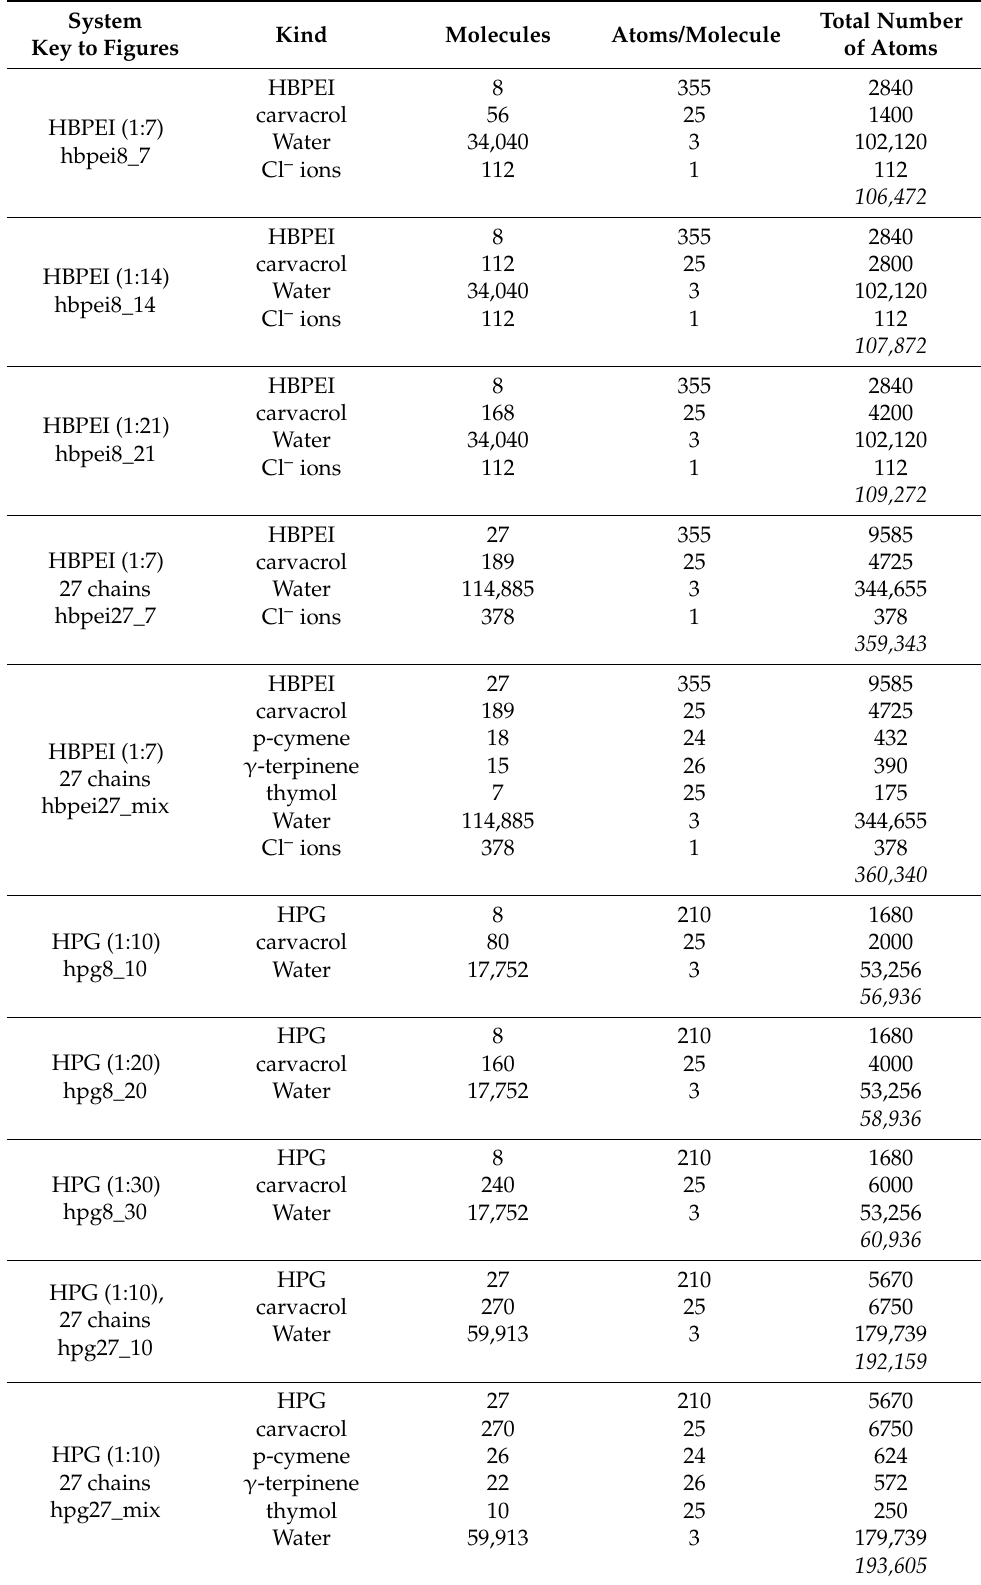
Table 2. Size and composition of terpenoid–polymer aquatic solutions. The numbers of the rightmost column shown in italics, denote the total number of atoms in each